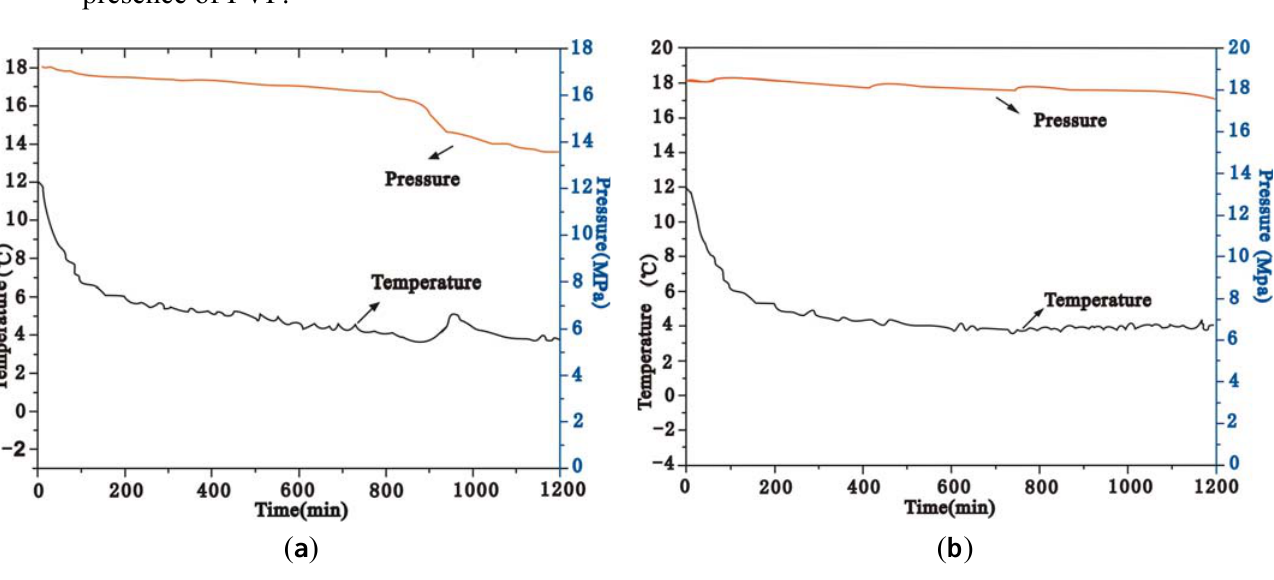
Figure 4. The contrast of temperature and pressure evolution of polyethylene glycol drilling fluid with and without the addition of PVP K-90 ( a ) in absence of PVP and ( b ) in presence of PVP.